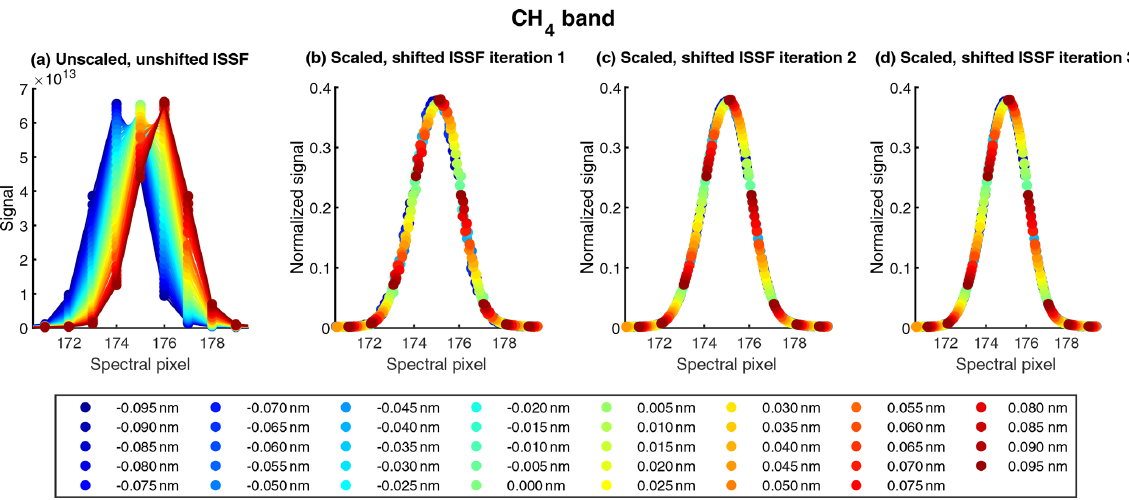
Figure 9. Demonstration of ISSF oversampling for the CH 4 band using a central wavelength of 1610nm and spatial pixel 500. The laser was scanned in 0.005nm steps over a range corresponding to the central wavelength ± 0.095nm. The resulting series of individual ISSFs (a) are then shifted and scaled to produce a single oversampled ISSF (b) . Successive iterations of shifting and scaling (c, d) are performed to construct smoother oversampled ISSFs, which can then be mapped from pixel space to wavelength space for ISRF analysis.